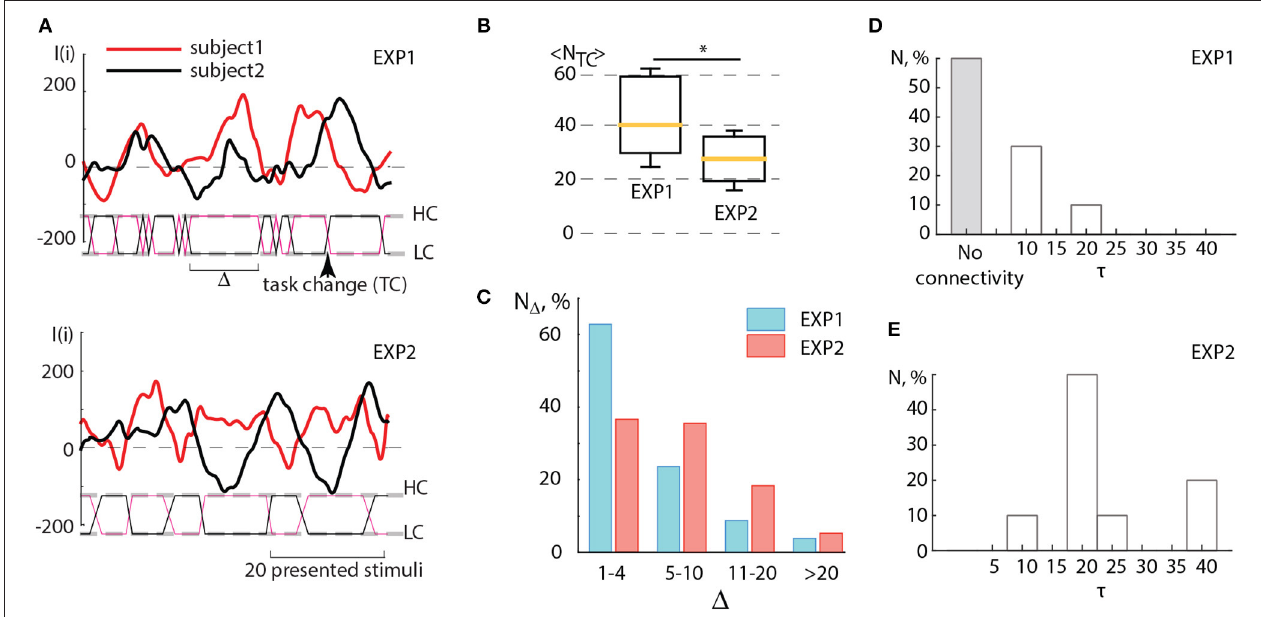
FIGURE 5 | (A) Detailed illustration of the BBI performance during experiments EXP1 and EXP2. Solid curves represent the brain response I ( i ) of two partners, dashed lines marked as HC and LC indicate two types of visual tasks associated with high and low complexity, solid lines between these dashed lines indicate switches (TC) between the tasks, the arrow shows the moment of a single switch. The length of the interval ( 1 ) between two successive switches is measured in the number of presented stimuli. (B) Comparison between the number of switches < N TC > averaged over subjects during experiments EXP1 and EXP2. Statistical significance is estimated via paired t -test. Medians (yellow bars), 25–75 percentiles (box) and outlines (whiskers) are shown. (C) Distribution of time intervals between switches 1 calculated by taking into account four ranges: rapid switches (1–4 units), medium switches (5–10 units), optimal switches (11–20 units) and long switches ( > 20 units). (D,E) Connectivity analysis. Histograms reflecting distribution of coupling time lags τ over all pairs of participants showing the change in the character of coupling in (D) EXP1 and (E) EXP2. * p < 0.05 by paired sample t -test.